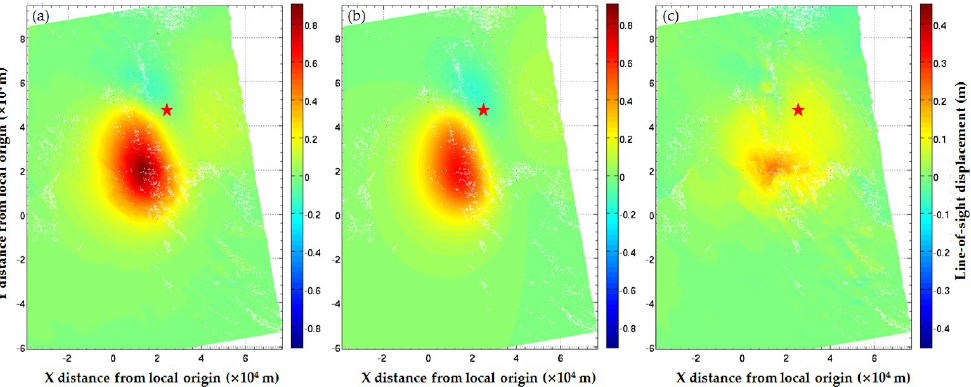
Figure 5. Uniform slip results of the ascending track: ( a ) observed, ( b ) synthetic, and ( c ) residual interferograms. Red stars represent the epicenter.